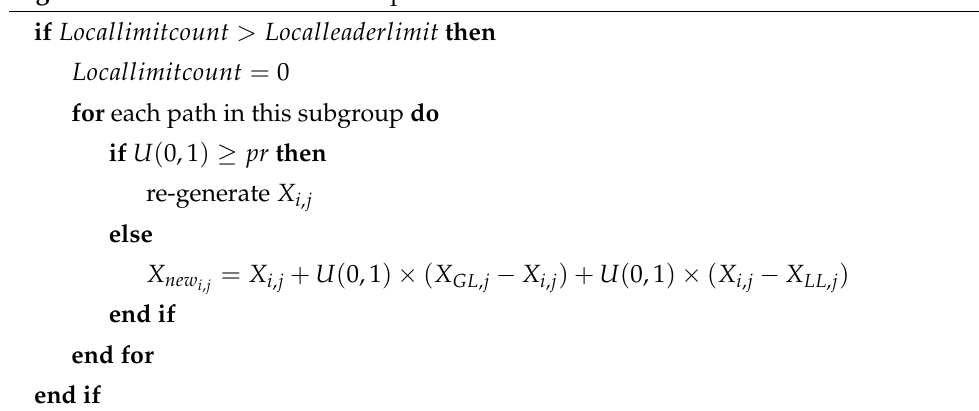
Algorithm 3 Local leader decision phase